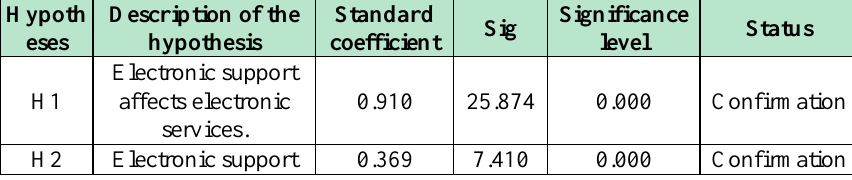
Table (3) Results of testing the main hypotheses of the research